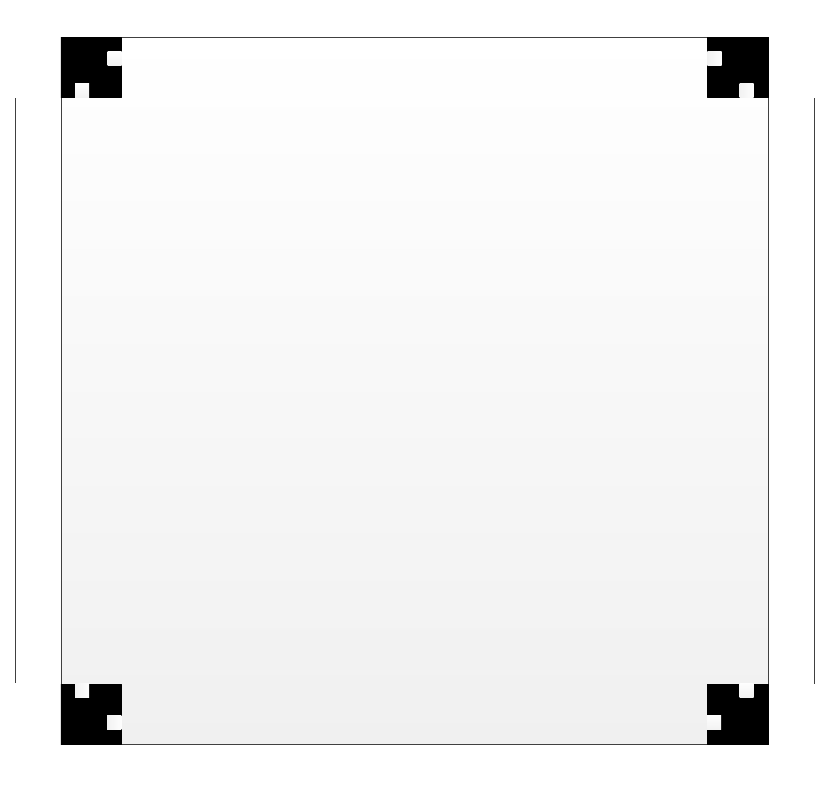
Figure 15. OPEN / OpenOrbiter Corner Post Configuration.